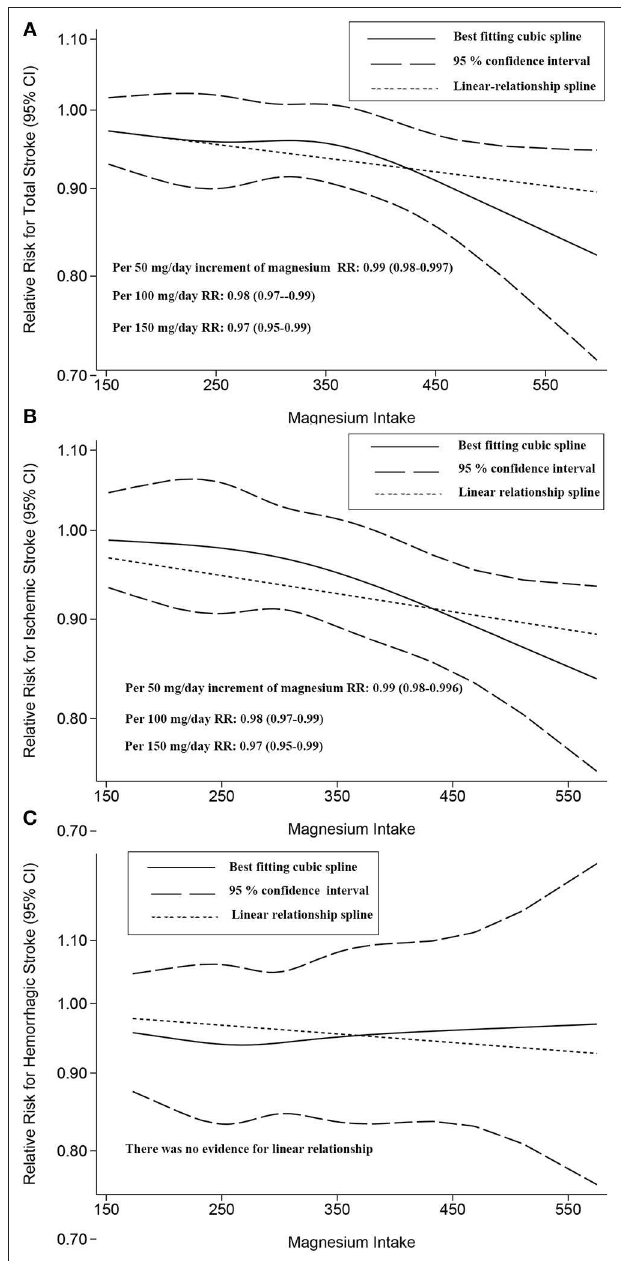
FIGURE 4 | Two-stage dose-response effects on the relationships between magnesium intake and total stroke (A) ; ischemic stroke (B) ; hemorrhagic stroke (C) . The solid line represents non-linear estimates of the association between Magnesium Intake and the risk of expected outcomes; the dashed lines are the 95% confidence intervals (95% CIs); the dotted line represents the linear estimates of the associations between magnesium intake and the risk of expected outcomes. The vertical axis is the relative risk (RR) scale without logarithmic transformation.